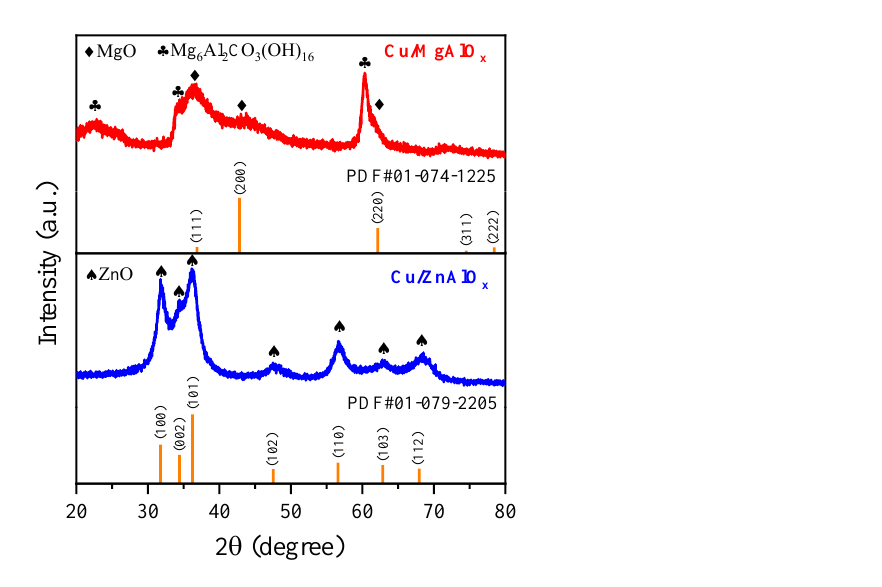
Figure 4. TEM and HRTEM images of different supported Cu catalysts: ( a , c ) Cu/MgAlO x ; ( b , d ) Cu/ZnAlO x .